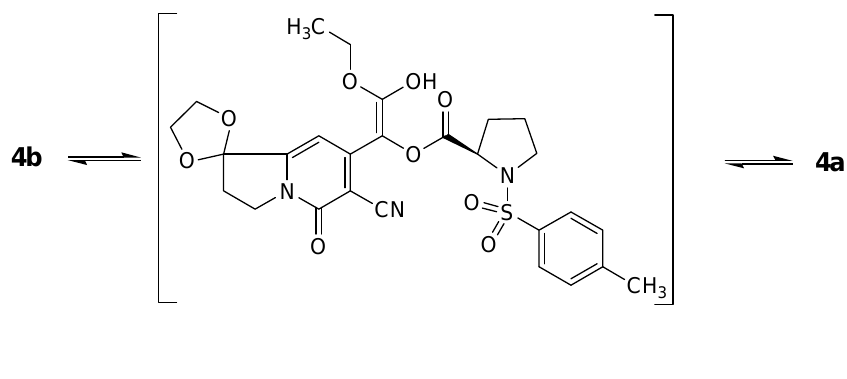
Figure 4. Dynamic equilibrium of enol tautomerism between 4a and